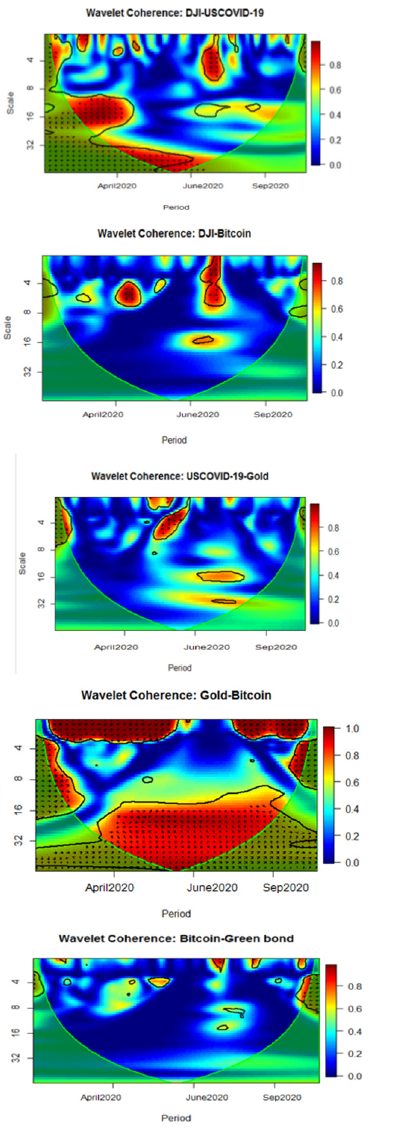
Figure 1. CWT Plots.